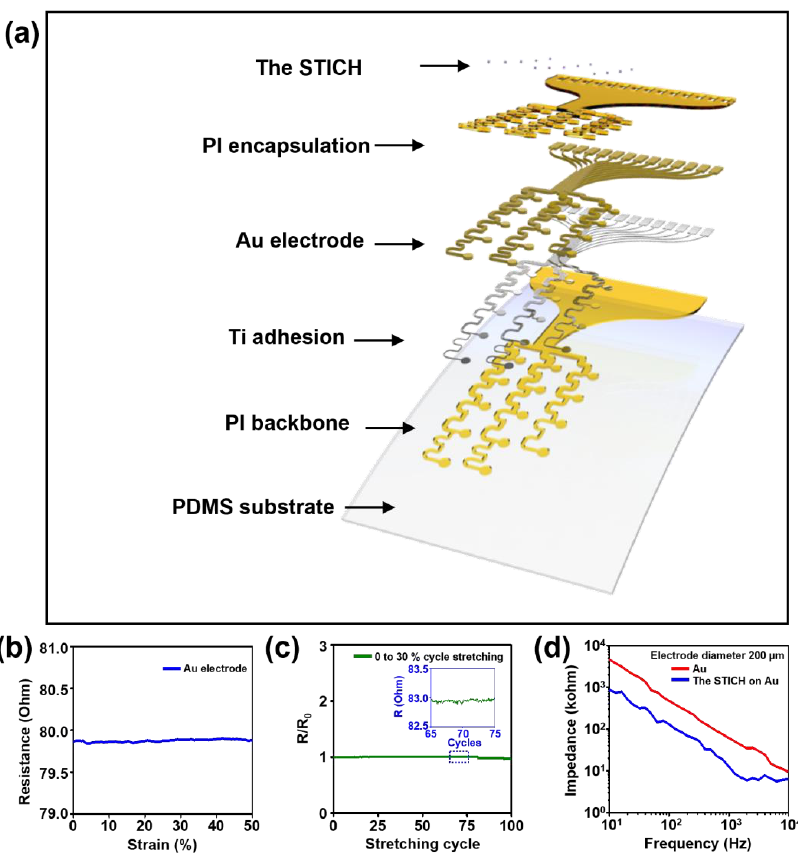
Figure 5. Electrical characteristics of the stretchable surface electrode arrays and the in vitro EIS analysis of the STICH − coated devices. ( a ) Exploded − view schematic of the stretchable surface elec- trode arrays. ( b ) Electrical resistance of the stretchable surface electrode while stretching up to 50 % strain. ( c ) Normalized electrical resistance during 100 stretching cycles up to 30% strain (inset: a representative plot of 10 cycles). ( d ) EIS plots of the Au electrode (red line) and the STICH − coated electrode (blue) with respect to frequency (from 100 kHz to 10 Hz). 3.5. In Vivo Experiment Results of Acute ECoG Monitoring To demonstrate the feasibility of the STICH for brain − interfacing applications, in vivo experiments for ECoG monitoring were conducted using the stretchable electrode arrays coated with the STICH brain − interfacing layer. In the acute experiments, an electrode ar- ray device with the STICH layer was attached to the left hemisphere of an anesthetized rat, and the baseline ECoG signals and event − related potentials (ERPs) from the visual cortex (VEP) activated by light stimulation of the right eye were recorded (Figure 6a). The direct contact between the STICH layers with the cortex permitted the construction of adaptive brain interfacing. The brain − like softness of the STICH provided excellent con- formality to electrodes, and the sufficient toughness allowed the STICH layer to maintain its solid form between the device and the tissue. The raw signal plot of the baseline ECoG activity from the surface electrodes mounted on the animal’s cortex (Figure 6b) and acti- vated VEP emphasized the selectivity of the 12 − channel STICH − based electrode arrays (Figure 6c). Moreover, the STICH − coated electrodes featured the capability of clearly re- cording visual cortex − originated ERPs (Figure 6d). The contribution of the STICH was